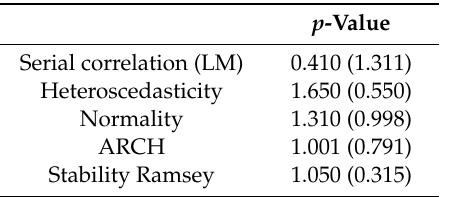
Table 8. Diagnostic test results for ARDL.